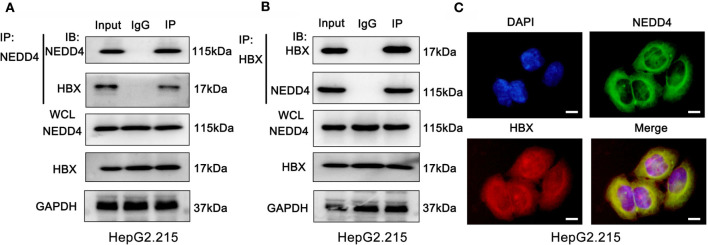
NEDD4 interacts with HBx in HBV-associated hepatocellular cells. (A) and (B) Coimmunoprecipitation was conducted with NEDD4 and HBx antibodies. The coimmunoprecipitated mixture was separated by SDS-PAGE and evaluated by immunoblotting. NEDD4 and HBx interact with each other in HepG2.215 cells. (C) Immunofluorescence assay demonstrated the colocalization of NEDD4 and HBx in HepG2.215 cells (green NEDD4, red HBx, blue, DAPI) (n = 3 independently replicated experiments; white scale bars: 10 μm). IP, Immunoprecipitation; IB, immunoblot; WCL, whole cells lysate.